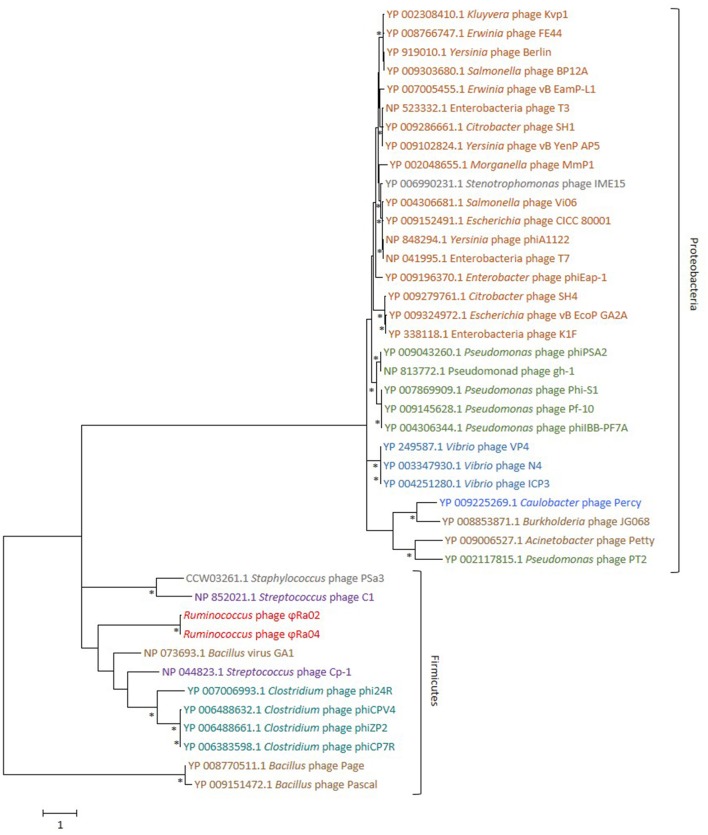
Maximum Likelihood phylogeny of the Podovirus head-tail connector protein sequences of the Ruminococcus phages ϕRa02 and ϕRa04 and 40 Podoviruses. The tree with the highest log likelihood (−19562.46) using the Le Gascuel model (Le and Gascuel, 2008) and a gamma distribution with five categories is shown. The rate variation model allowed for some sites to be evolutionarily invariable (0.02% sites). This tree used a total of 707 amino acid positions and is drawn to scale, with branch lengths measured in the number of substitutions per site. The tree is rooted with head-tail connector protein sequences of two Bacillus megaterium phages and bootstrap supports greater than 85%, based on 1,000 replicates, are indicated (*). Major phyla are bracketed and phage names and accession numbers are colored according to the phage-host family (Enterobacteriaceae •), genera (Pseudomonas
•, Vibrio
• and Ruminococcus
•, Clostridium •) or environmental source (soil-associated Bacillus and Acinetobacter
•, human respiratory tract associated Streptococcus
• and water-associated Caulobacter
•). Names of phages with hosts classified outside of these taxons or of unknown isolation source (Stenotrophomonas and Staphylococcus) are colored gray •.